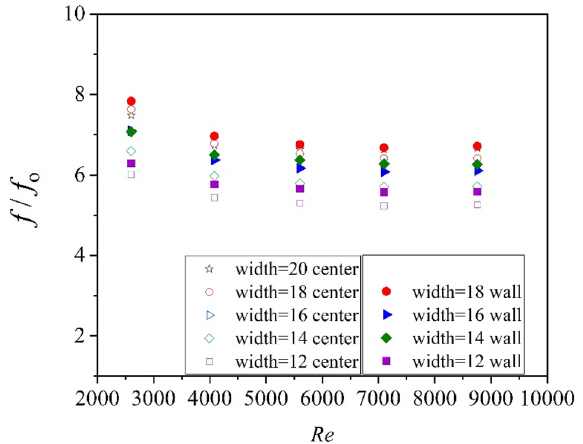
Figure 11. Friction factor versus Reynolds number.